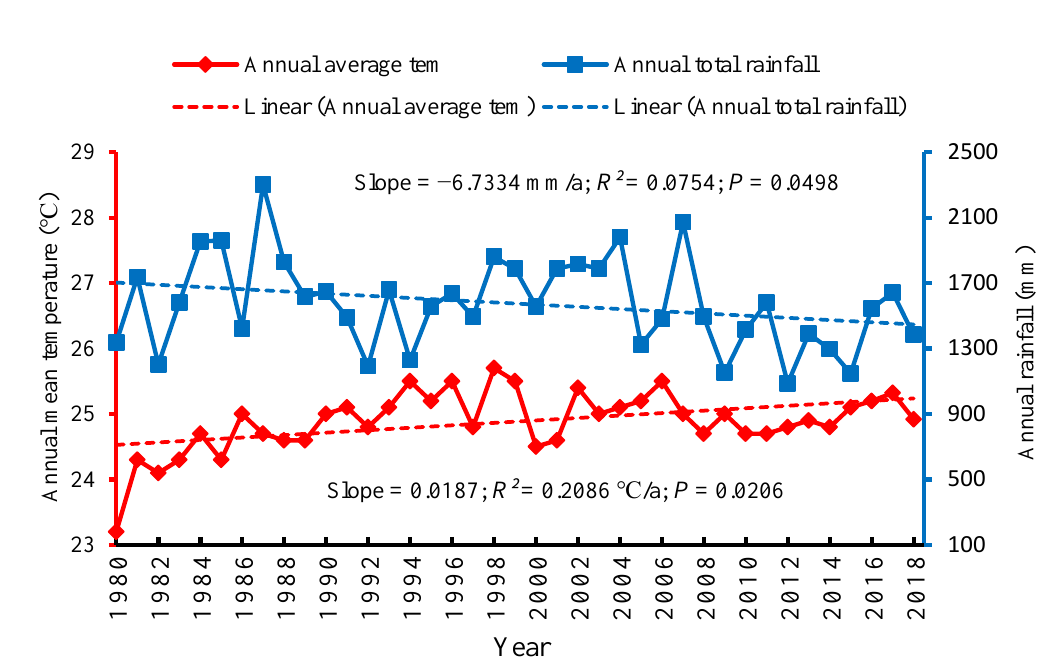
Figure 4. Climatic trend in the Tarai region of the trans-boundary KRB.